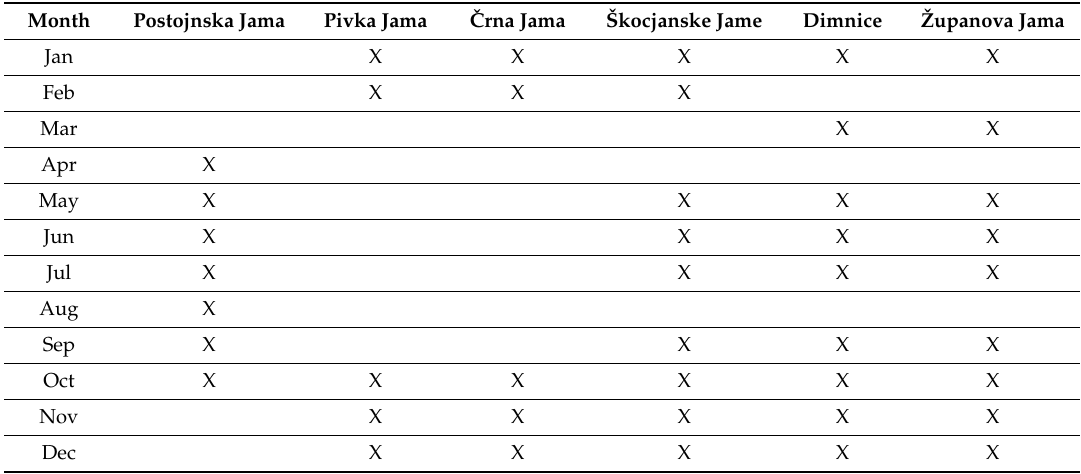
Table 1. Summary of sampling coverage of the six study caves, by month. An X indicates that all of the drips in the cave were sampled for physico-chemical parameters, at least once. Data from